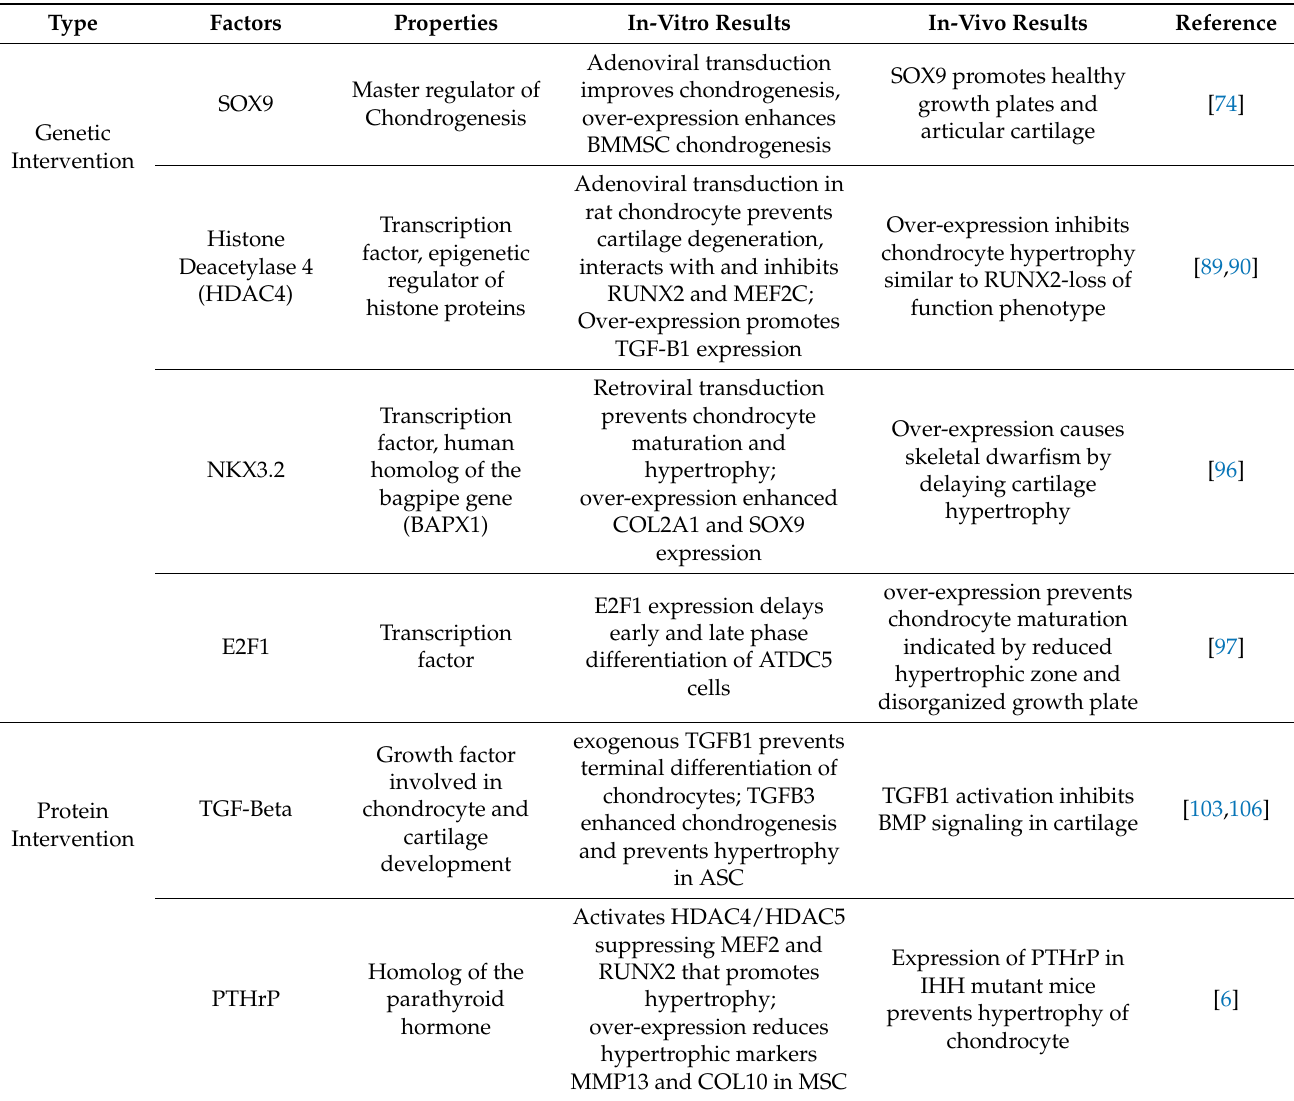
Table 1. Summary of gene and protein interventions for chondrocyte